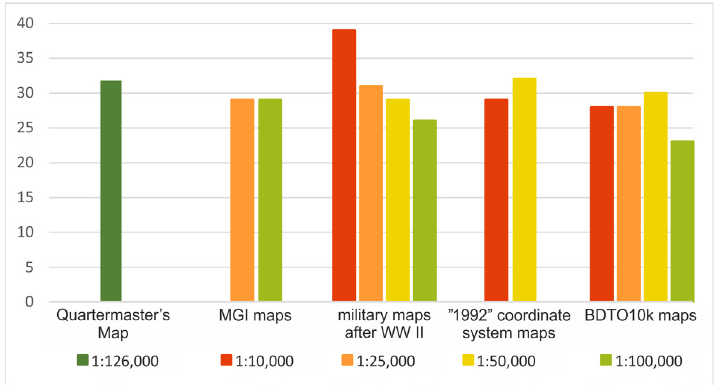
Fig. 8. Number of characteristics of built-up